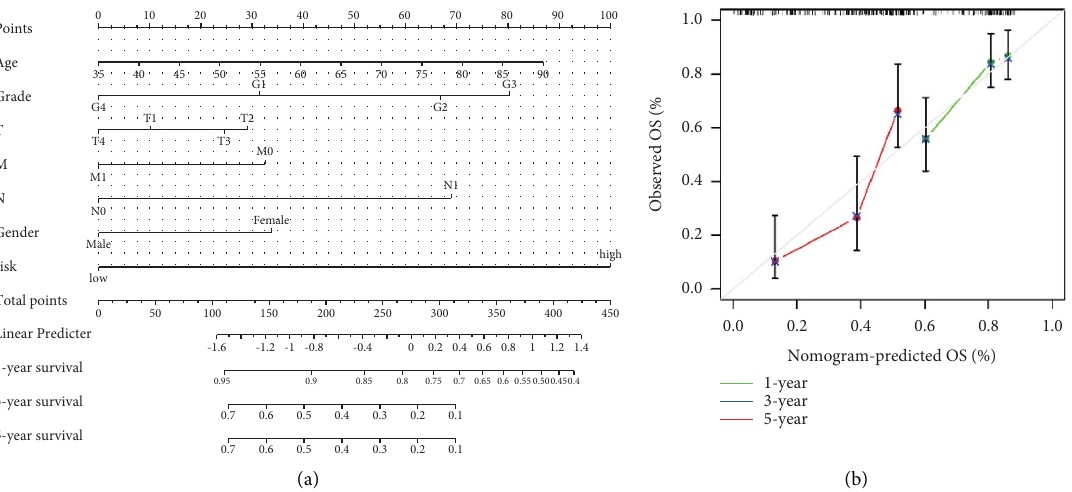
Figure 7: Te nomogram to anticipate prognostic probabilities in pancreatic cancer. (a) Nomogram based on risk score and clinico- pathological characteristics. (b) Te calibration curves of the nomogram in the training set, which was used to predict the 1-, 3-, and 5-year